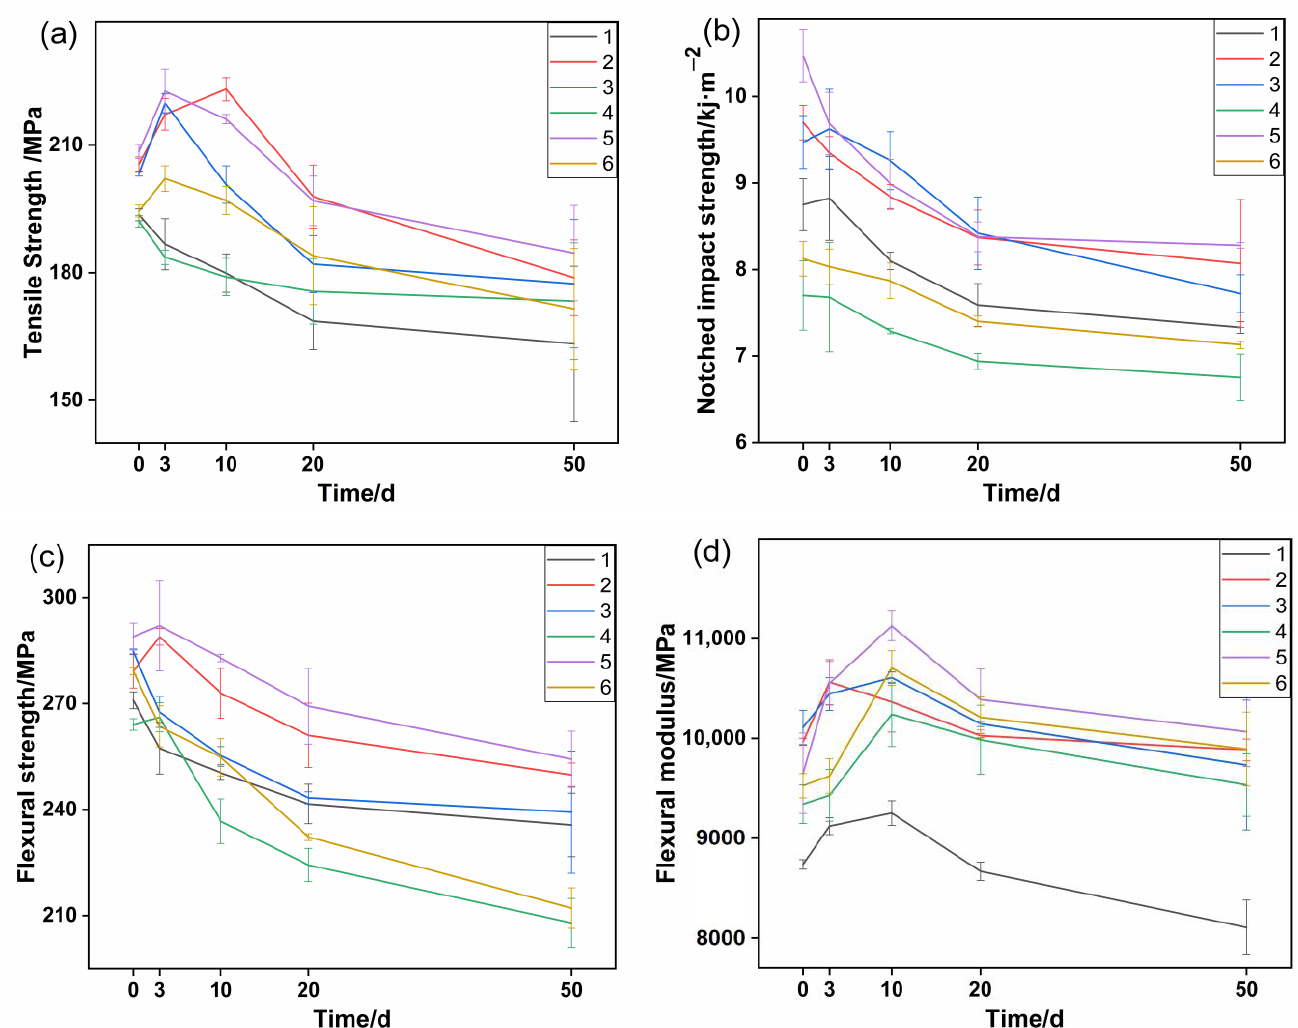
Figure 8. The effect of aging time on mechanical properties: ( a ) tensile strength, ( b ) notched impact strength, ( c ) flexural strength, ( d ) flexural modulus.